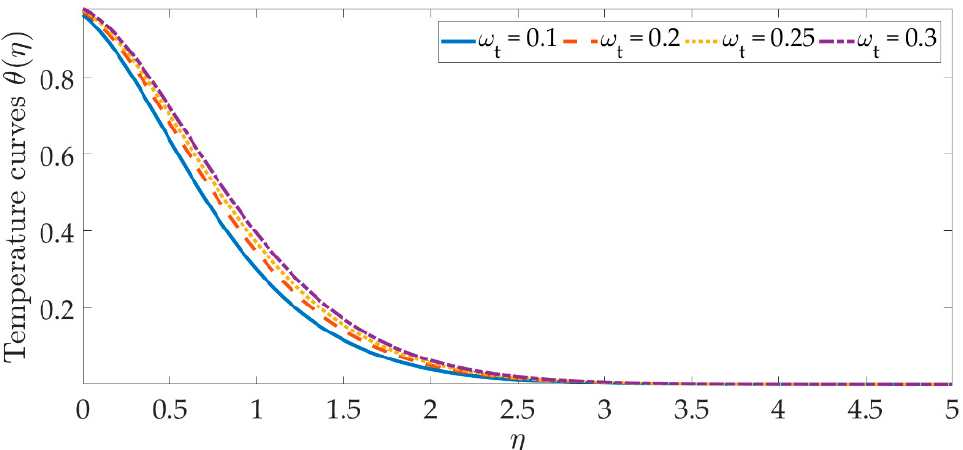
Figure 10. Temperature curves against the multiple values of . b